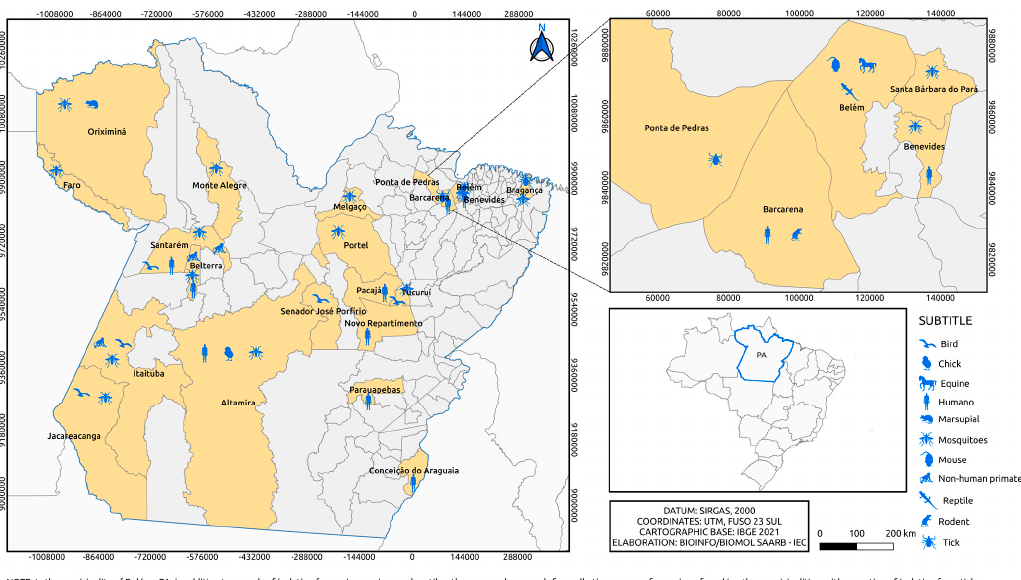
Figure 4. Municipalities in Par á state where alphaviruses were isolated over 6 decades by the